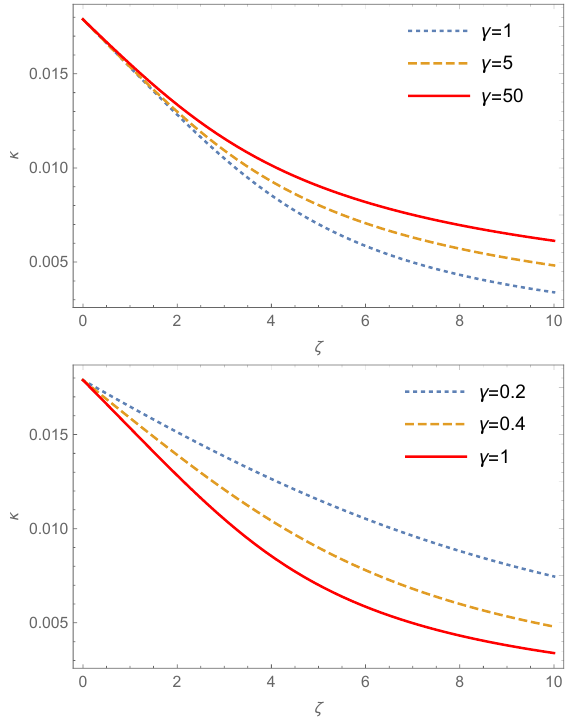
Figure 8 . The dependence of the transition rate of the Hawking-Page phase transition from the large SAdS black hole state to the thermal AdS state on the friction coefficient ζ for the oscillatory friction kernel. In the plot, L = 1 , T = 0 . 5 , and ˜ ω = π panel is for γ < 1